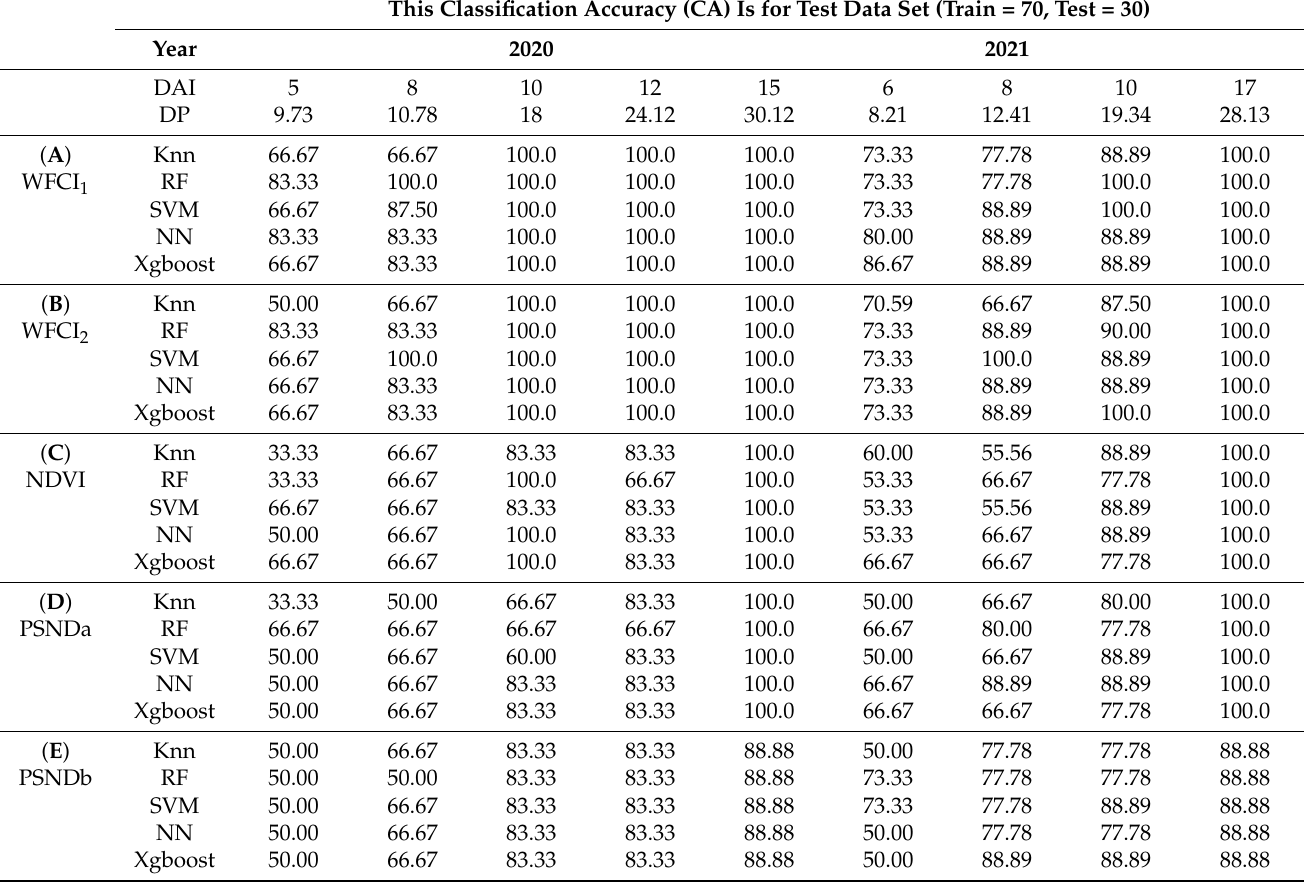
Table 2. Classification accuracy of the newly developed and conventional spectral indices employing different machine learning classifiers. Overall Classification Accuracy